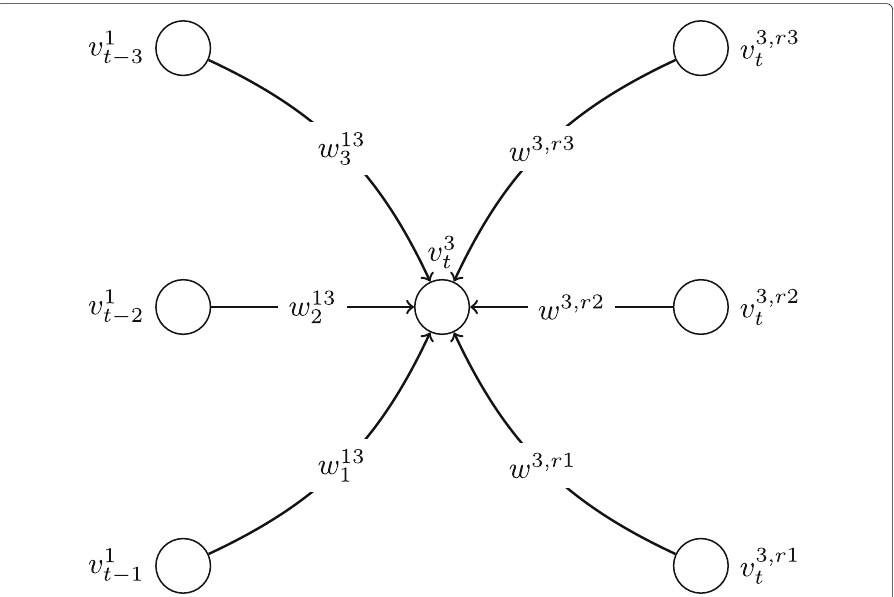
Fig. 7 Example connector for modeling the time-varying activation-threshold in the serialized graph under a competitive